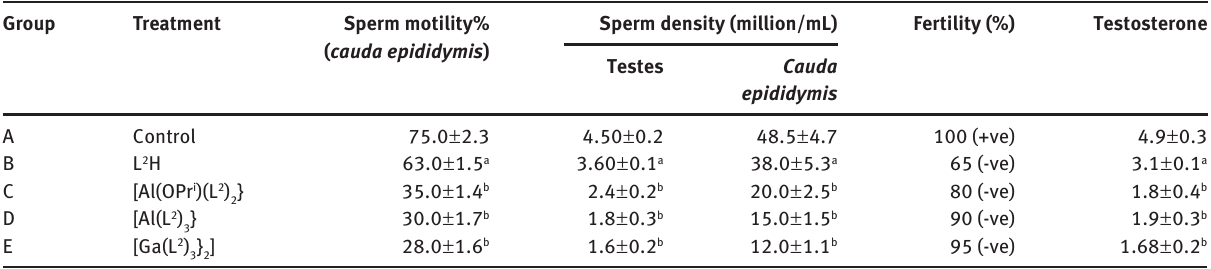
Table 8 Sperm dynamics and fertility after the administration of the ligand (L 2 H) and its corresponding complexes.